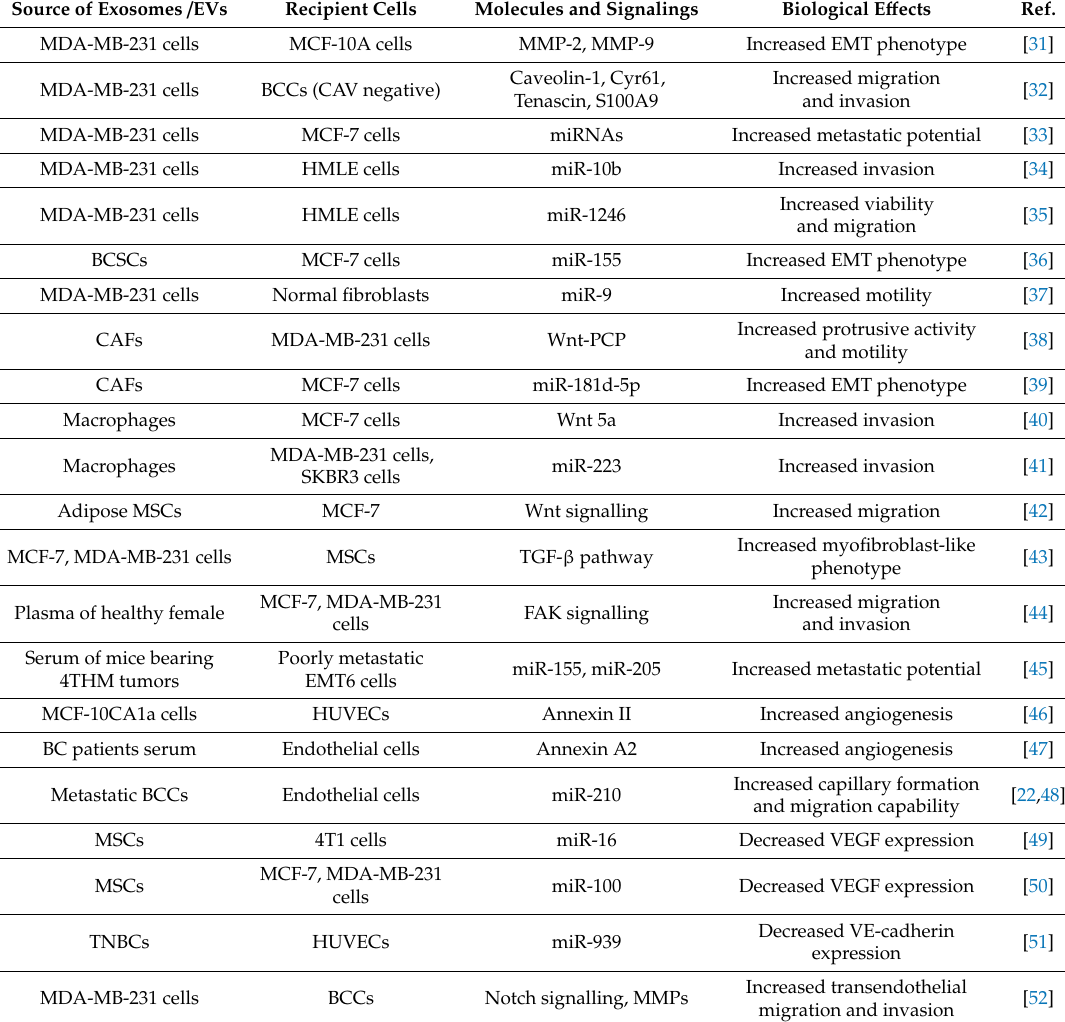
Table 1. Exosome-mediated mechanisms sustaining metastatic process in breast